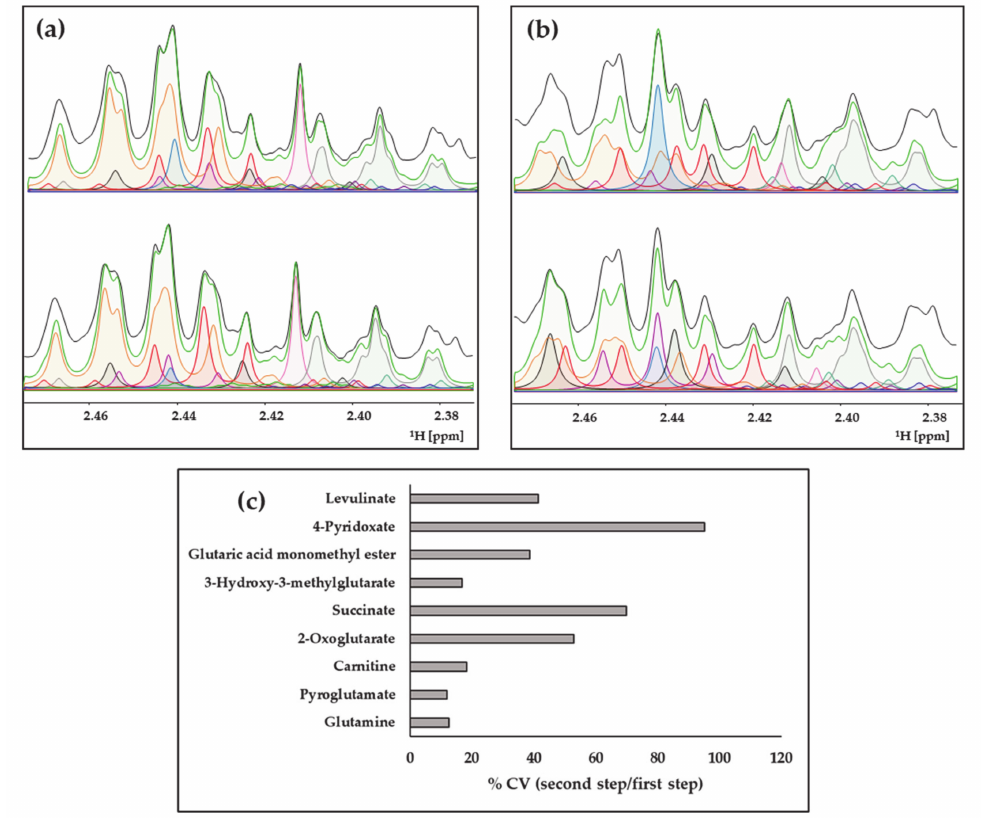
Figure 2. Example of the deconvolution process for two different samples ( a , b ) in the zone between 2.47 and 2.37 ppm. The first and second deconvolution steps are shown in the upper and lower panels for each spectrum, respectively. Black and green lines represent the experimental and calculated spectra, respectively. Signals from glutamine (orange), 2-oxoglutarate (light purple), carnitine (red), 3-hydroxy-3-methylglutarate (black), 4-pyridoxate (blue), trans-4-hydroxyproline (light green), pyroglutamate (gray), glutaric acid monomethyl ester (dark green), succinate (pink), levulinate (dark purple), and 3-hydroxybutyrate (electric blue) are shown. ( c ) Percent coefficients of variation